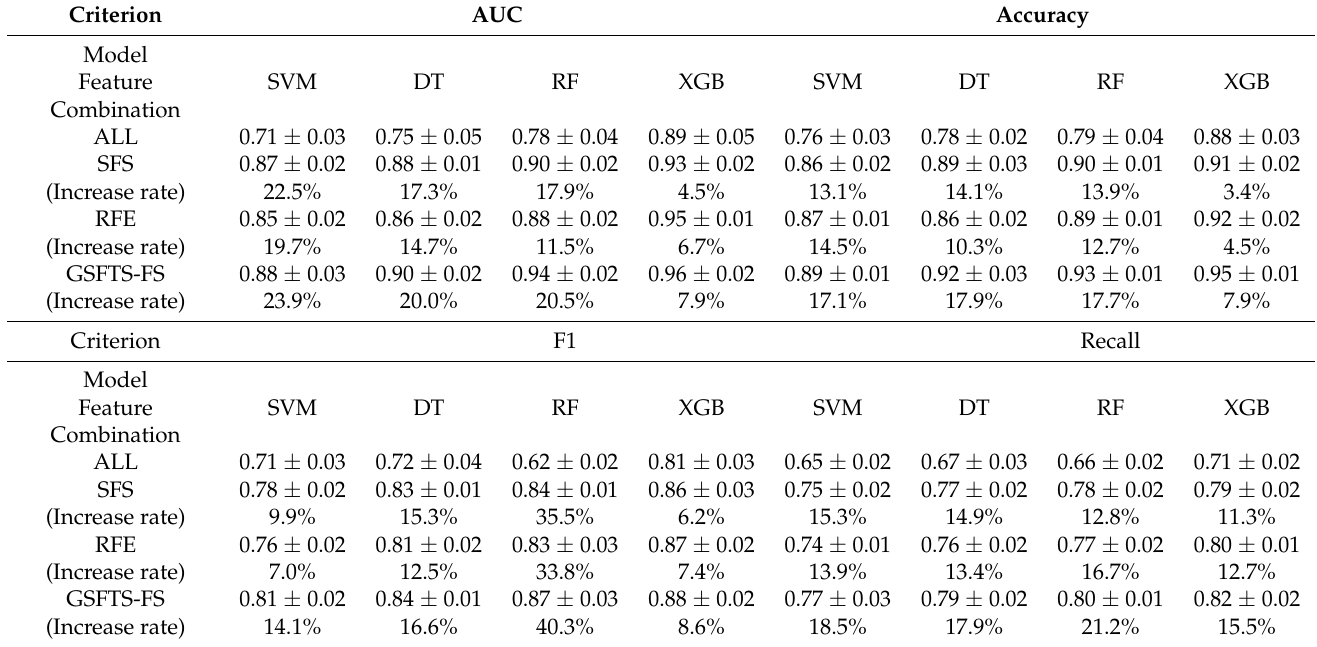
Table 8. Prediction results of different methods and criterion using 10-fold cross validation.